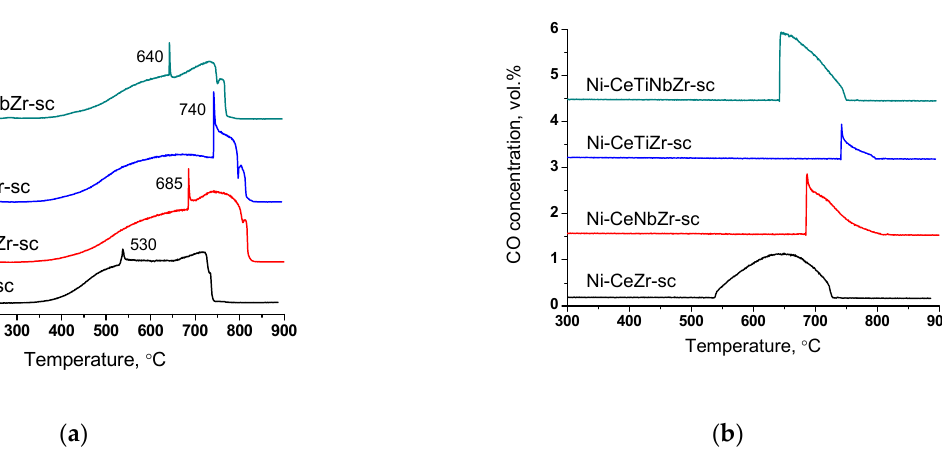
Figure 11. Weight loss during TGA of catalysts prepared by supercritical synthesis after long-term stability tests in methane dry reforming.